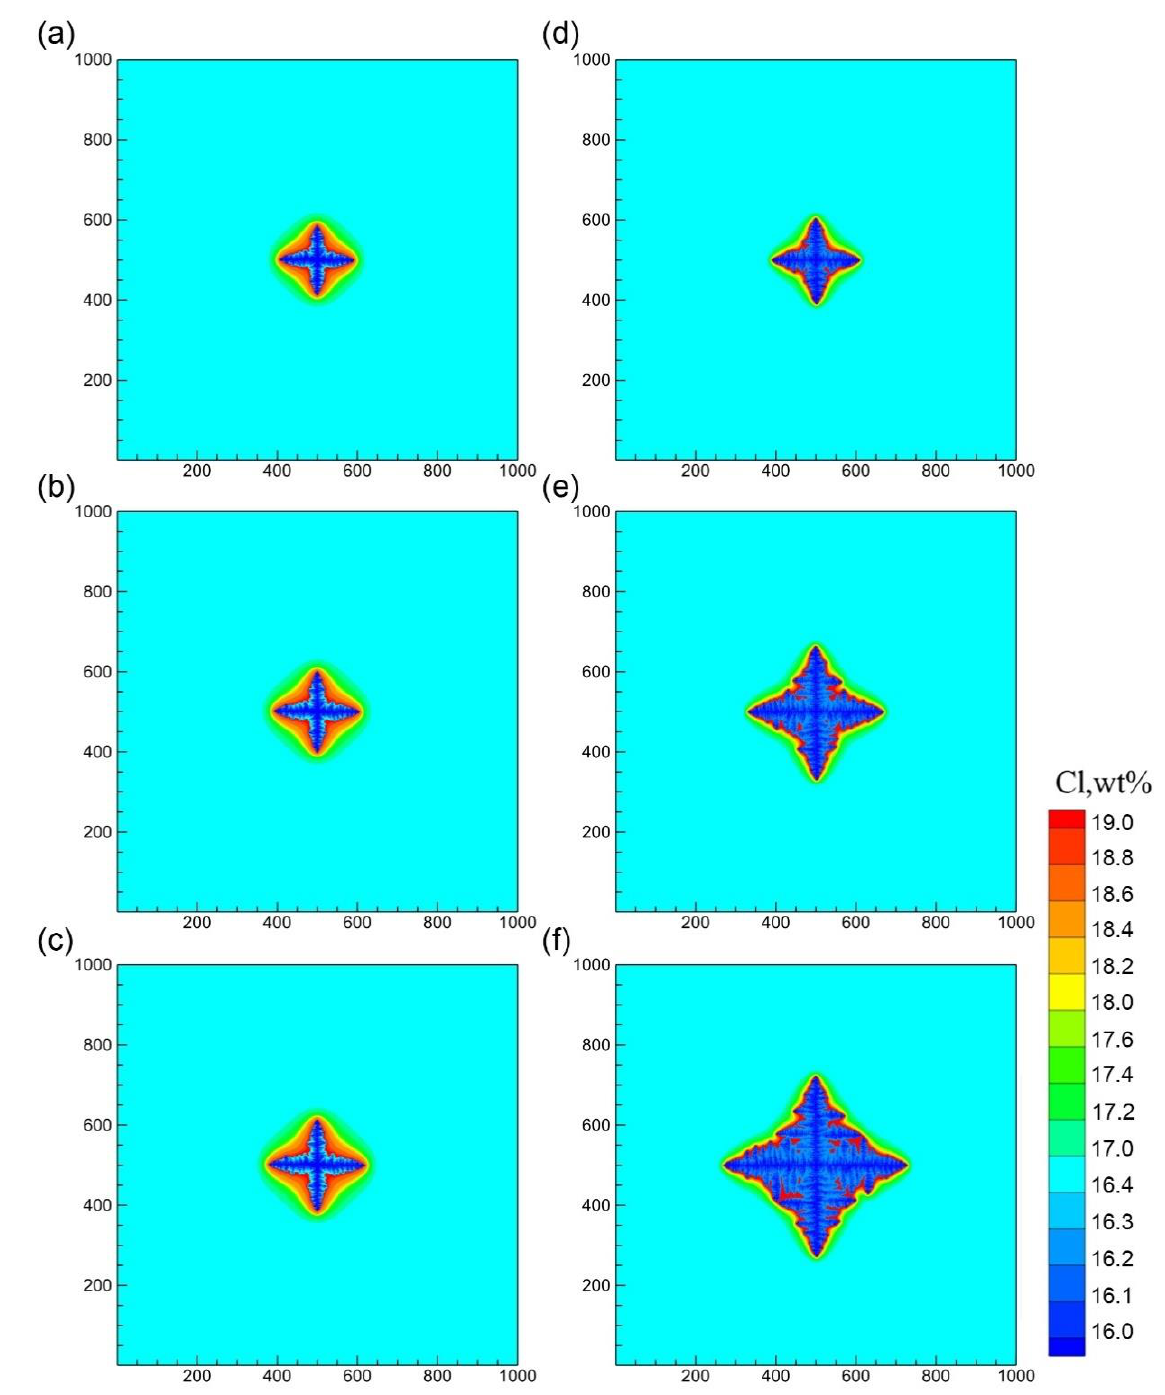
Figure 2. The process of a single equiaxed dendrite growing at the undercooled melt with different undercooling. ( a )–( c ) dendrite growing from at ∆T = 5 K after 0.24 s, 0.28 s, 0.32 s. ( d )–( f ) dendrite growing from at ∆T = 10 K after 0.12 s, 0.16 s, 0.2 s.